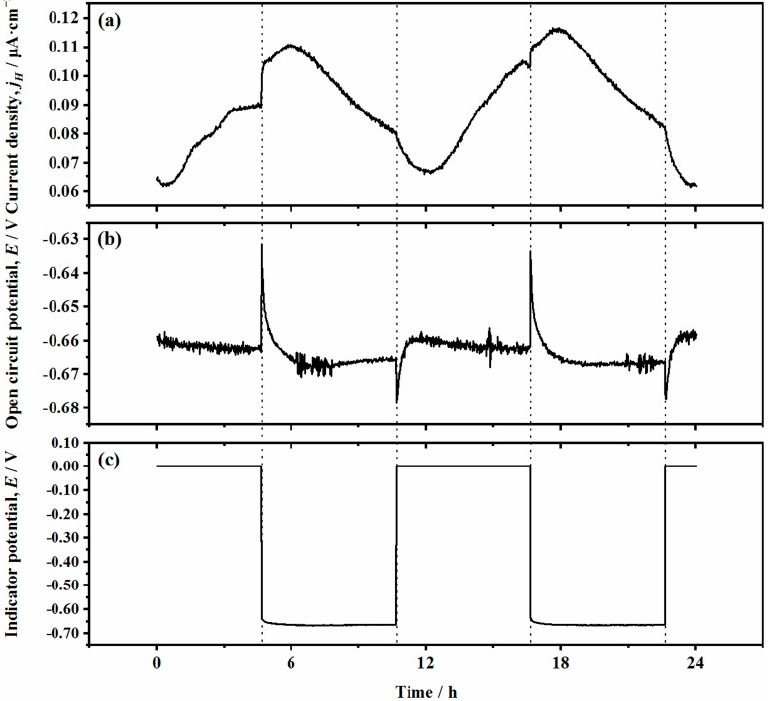
Figure 15. Variations of the hydrogen permeation current density ( a ) and open circuit potential ( b ) of the sensor, and indicator potential ( c ) under the simulated wet–dry cycle condition.